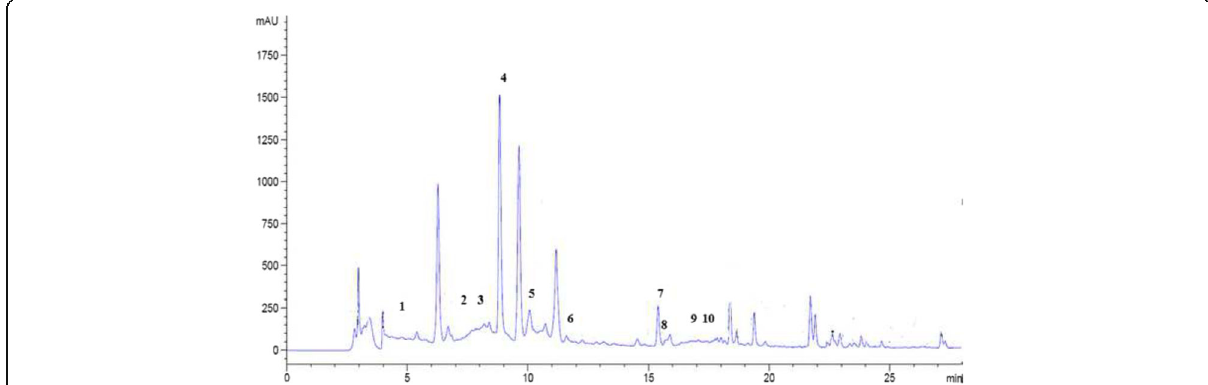
Fig. 1 HPLC chromatogram of a standard mixture of polyphenolic compounds. Peaks:1, Hydroxytyrosol; 2, Tyrosol; 3, 4HObenzoic; 4,verbascoside;